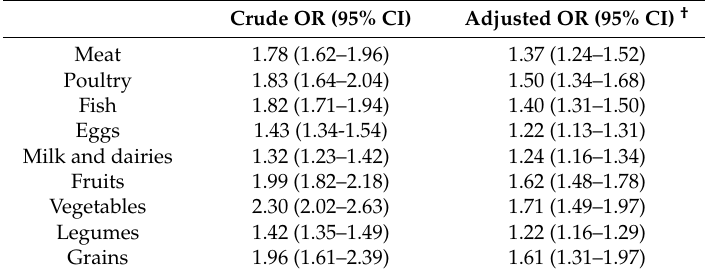
Table 3. Odds-Ratios (95% confidence interval) for the association of food item exclusion with depressive symptoms in logistic regressions.